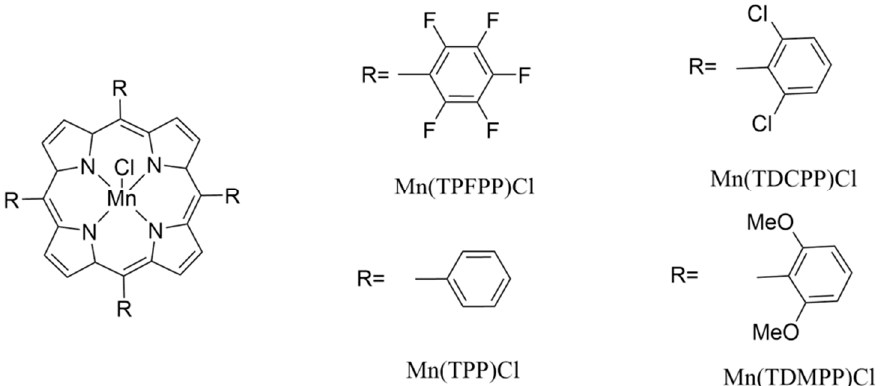
Figure 1. Structure of the metalloporphyrin related structures, used to coat the piezoelectric quartz crystal.